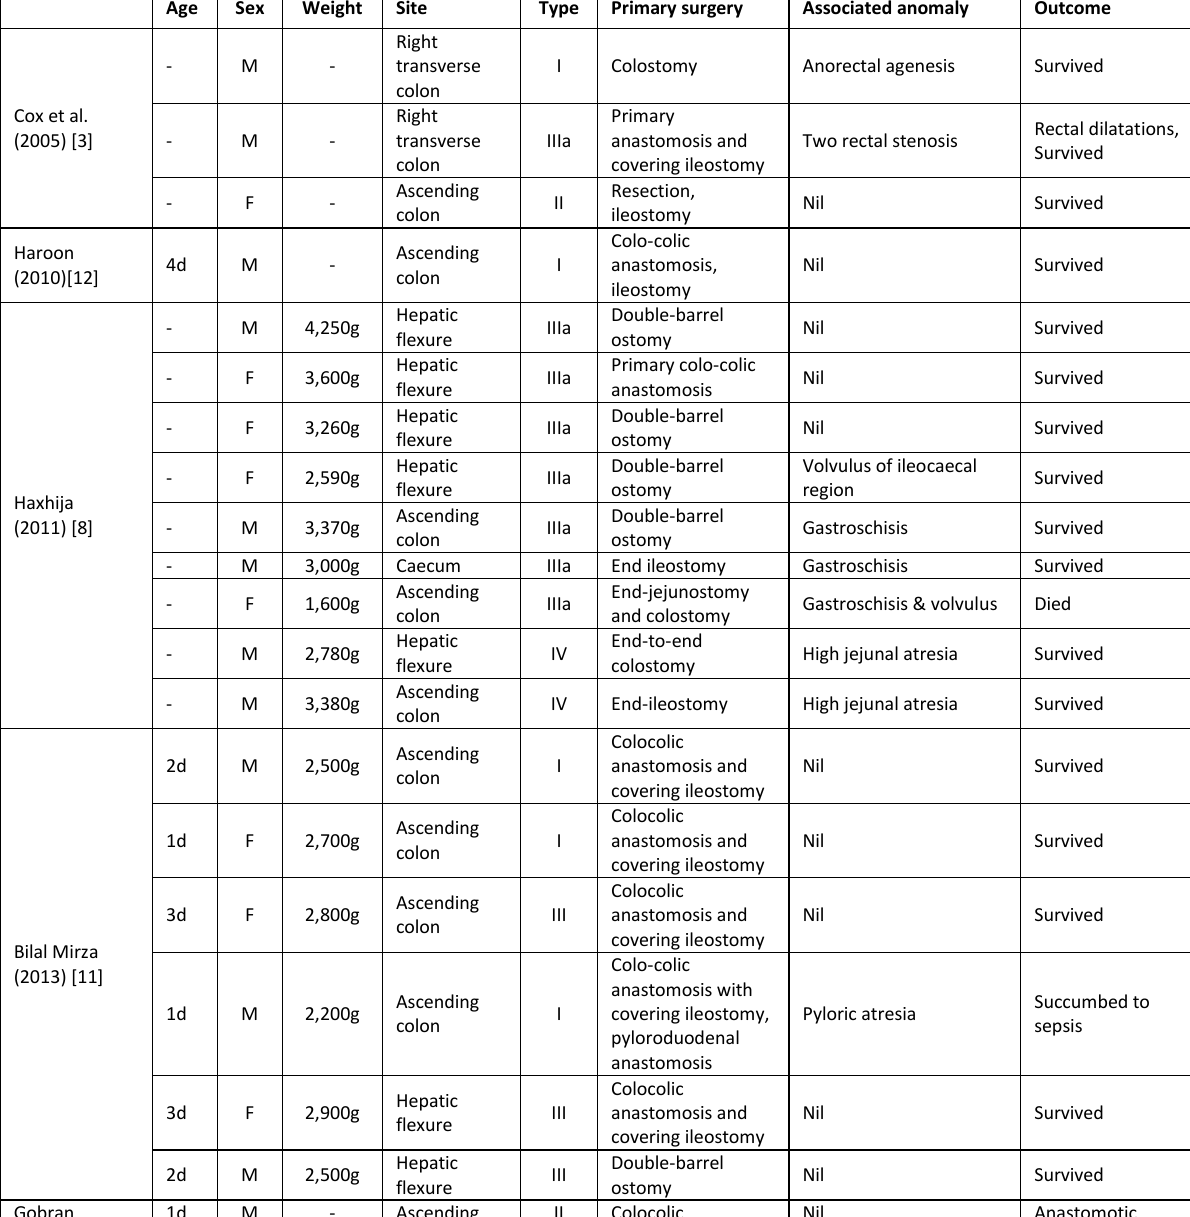
Table 1: Details of various reported cases of right-sided colonic atresia